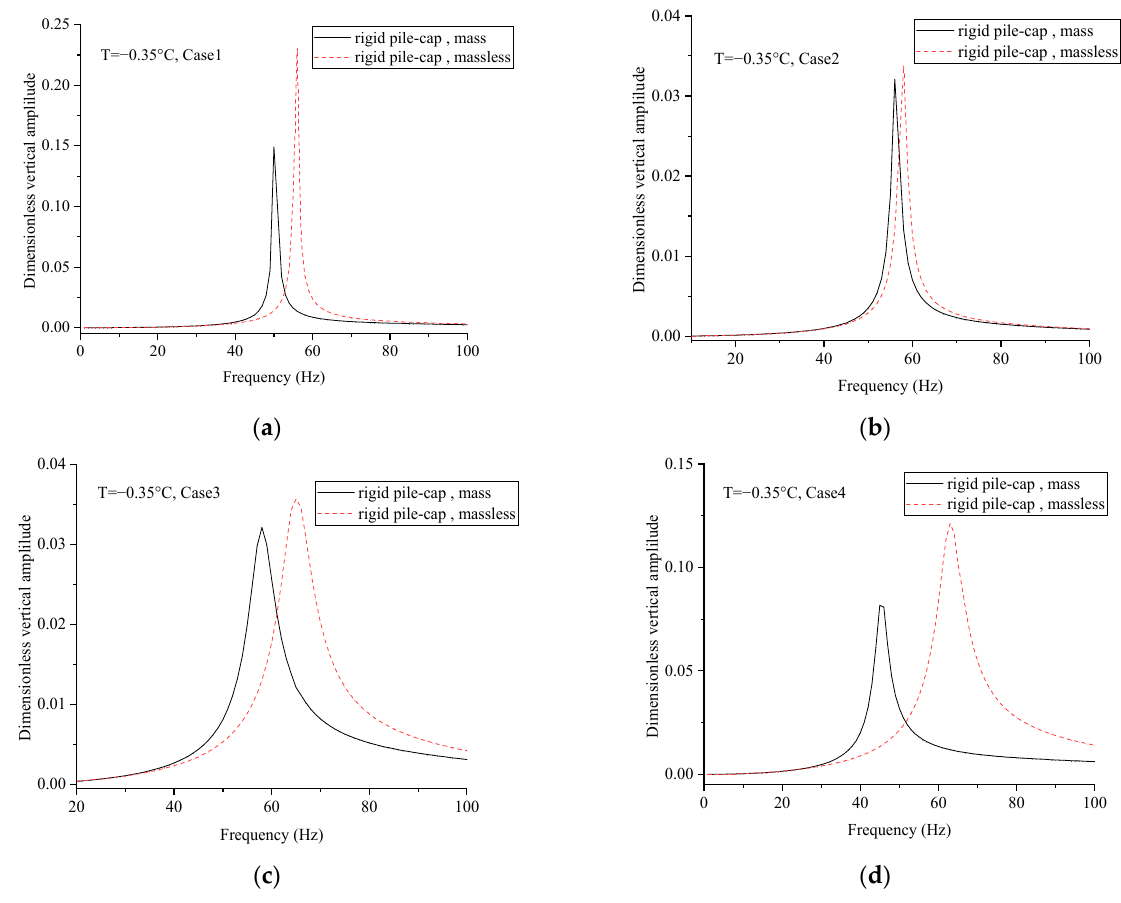
Figure 5. Comparison of the amplitude–frequency curves of the pile foundation with/without the mass of the pile cap. ( a ) Case 1; ( b ) Case 2; ( c ) Case 3 and ( d ) Case 4.